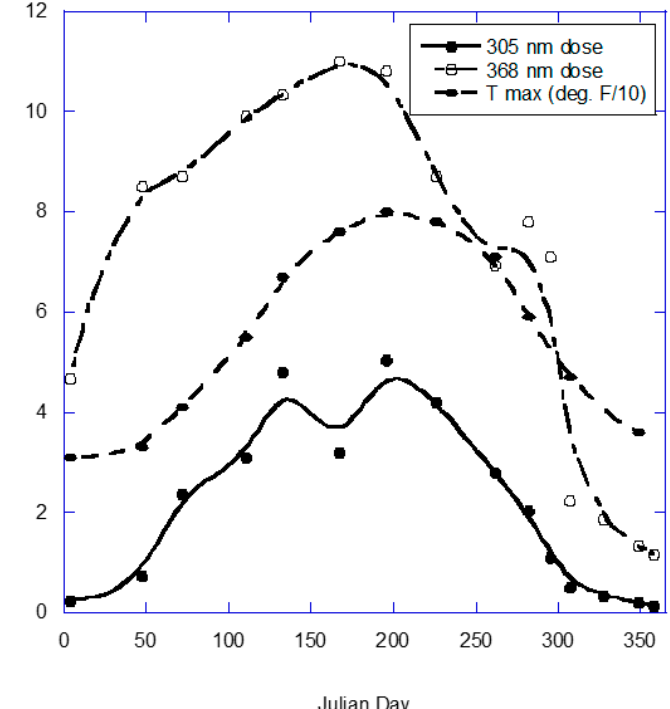
Figure 3. Annual variation for solar UVA and UVB in Geneva, NY, USA (42.9 ◦ N) for July 2006 to June 2007, as well as the temperature for 2021. UV data are from the UV-B Monitoring and Research Program operated by Colorado State University for the U.S. Department of Agriculture, https: //uvb.nrel.colostate.edu/UVB/da_queryLampIrradiance.jsf (accessed on 1 June 2022). Temperature data are from https://www.usclimatedata.com/climate/geneva/new-york/united-states/usny0548 (accessed on 1 June